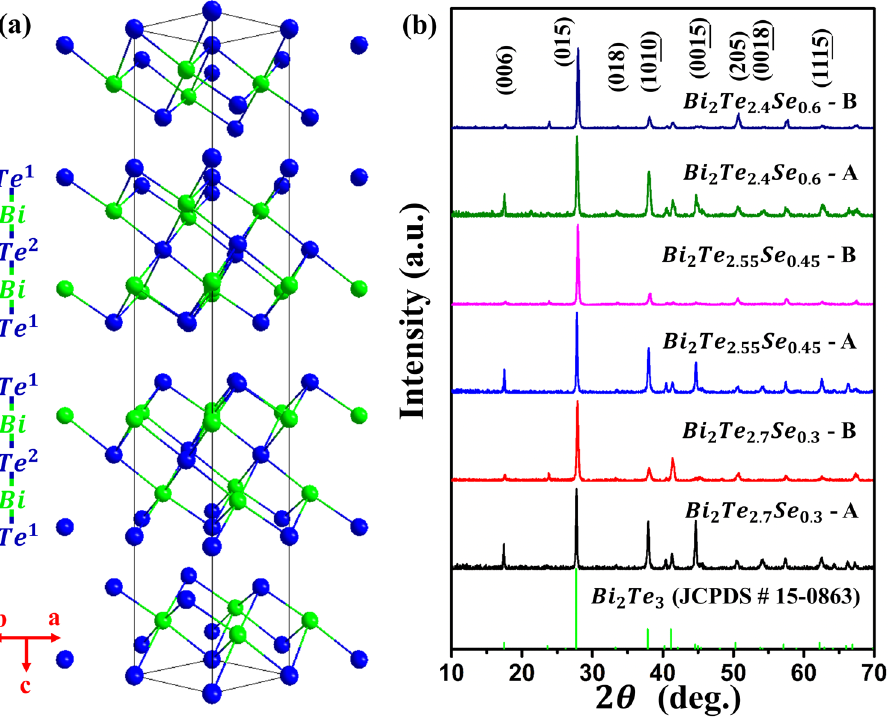
Figure 5. ( a ) Schematic diagram of the Bi 2 Te 3 crystal structure; ( b ) XRD pattern of radial surfaces of as-cast Bi